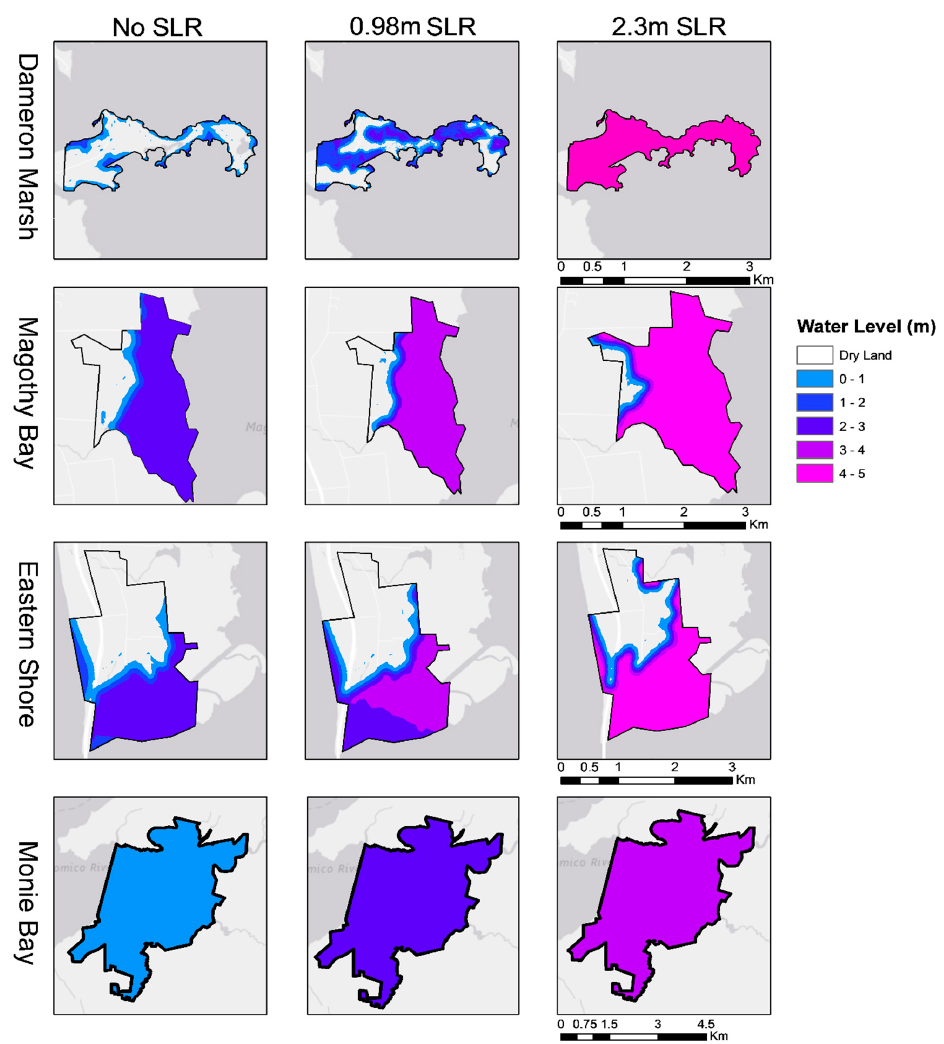
Figure 8. Current and future SLR scenario Inundation maps for the selected preserve areas in the Chesapeake Bay. Chesapeake